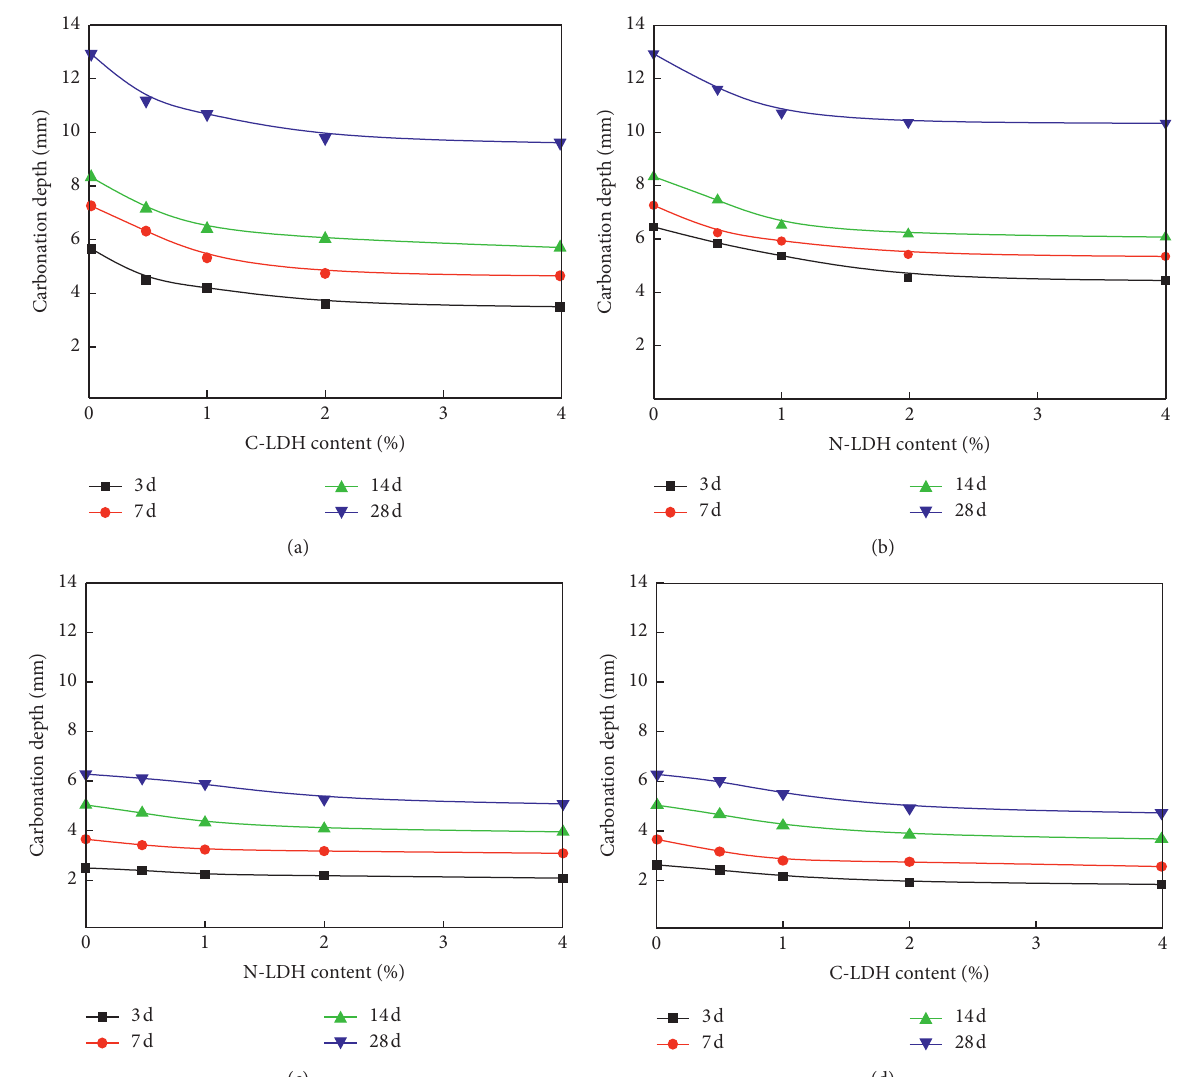
Figure 13: Relationship between carbonation depth of concrete and content of LDHs. (a) C30 with N-LDH. (b) C30 with C-LDH. (c) C50 with N-LDH. (d) C50 with C-LDH.